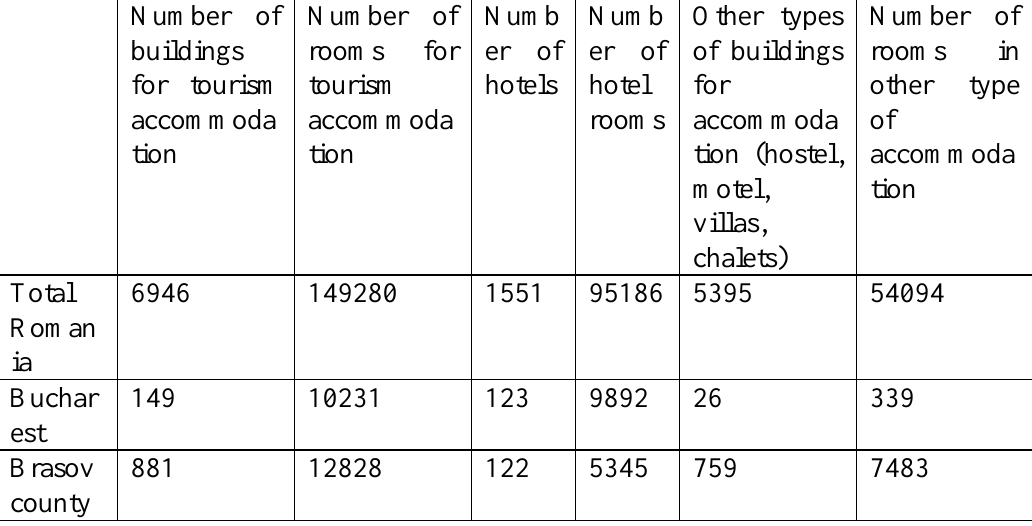
Figure 5 : Statistic for official tourism accredited accommodation at 31.07.2016